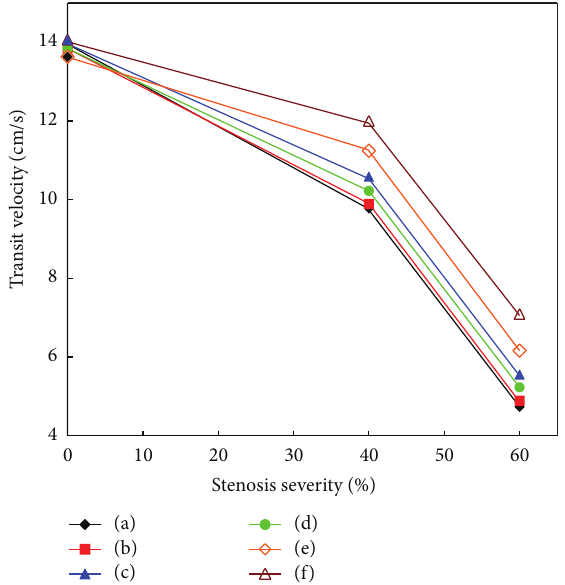
Figure 14: The effect of stenosis severity on the transit velocity of the aggregates for various simulation conditions: (a) the initial configuration for the aggregate is shown in Figure 1(c), and the aggregate is horizontally placed in the trapezoidal stenotic channel initially, 𝐷 𝑒 = 1.0 × 10 −2 𝜇 J/m 2 , 𝑘 𝑏 = 5.0 × 10 −13 Nm; (b) the initial configuration for the aggregate is shown in Figure 1(d), and the aggregate is horizontally placed in the trapezoidal stenotic channel initially, 𝐷 𝑒 = 1.0 𝜇 J/m 2 , 𝑘 𝑏 = 5.0 × 10 −13 Nm; (c) the initial configuration for the aggregate is shown in Figure 1(c), and the aggregate is vertically placed in the trapezoidal stenotic channel initially, 𝐷 𝑒 = 1.0 × 10 −2 𝜇 J/m 2 , 𝑘 𝑏 = 5.0 × 10 −13 Nm; (d) the initial configuration for the aggregate is shown in Figure 1(e), and the aggregate is vertically placed in the trapezoidal stenotic channel initially, 𝐷 𝑒 = 1.0 × 10 −2 𝜇 J/m 2 , 𝑘 𝑏 = 3.0 × 10 −12 Nm; (e) the initial configuration for the aggregate is shown in Figure 1(c), and the aggregate is horizontally placed in the sinusoidal stenotic channel initially, 𝐷 𝑒 = 1.0 × 10 −2 𝜇 J/m 2 , 𝑘 𝑏 = 5.0 × 10 −13 Nm; (f) the initial configuration for the aggregate is shown in Figure 1(c), and the aggregate is vertically placed in the sinusoidal stenotic channel initially, 𝐷 𝑒 = 1.0 × 10 −2 𝜇 J/m 2 , 𝑘 𝑏 = 5.0 × 10 −13